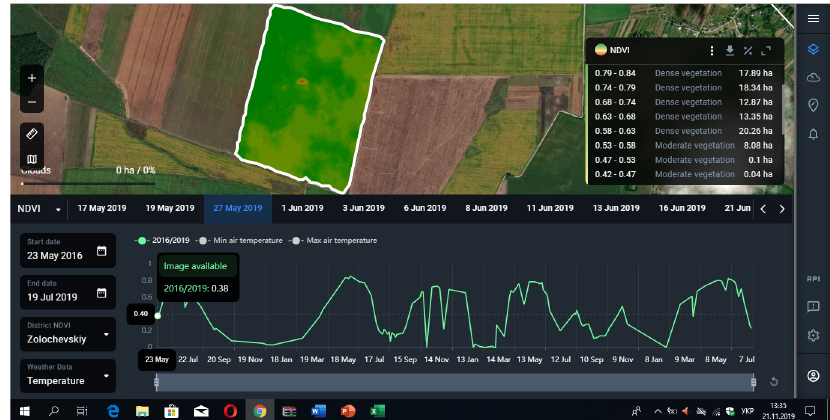
Figure 2. Image of the NDVI curve of annual flow for 2016–2019 and the state of land use by vegetation index as of May 27, 2019